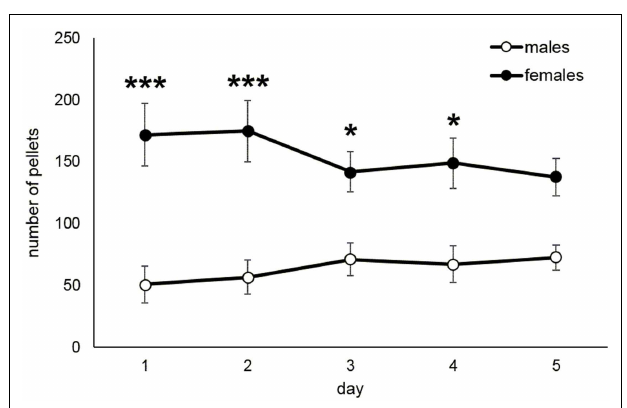
self-administration. The bar graph (B) depicts the mean day the animals reached and kept 70% preference of the active operandum: 4.7 in males and 2.2 in females (Mann–Whitney U test, p = 0.014).